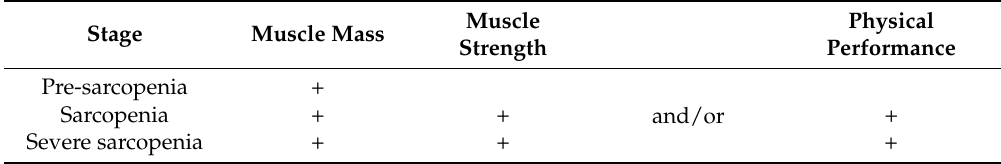
Table 1. Diagnostic criteria of sarcopenia according to the European Working Group on Sarcopenia in Older People